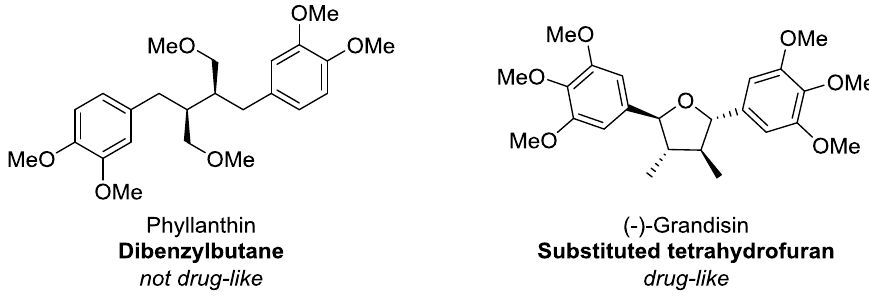
Figure 12. Structures of phyllanthin and (−)-grandisin.